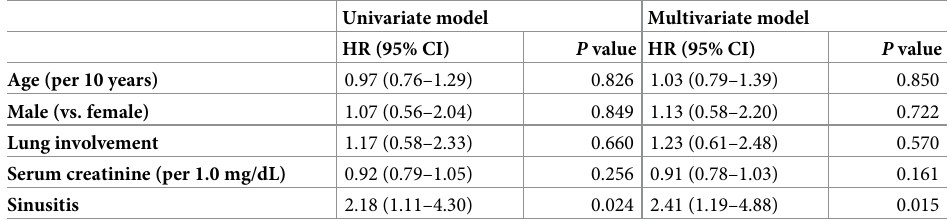
Table 2. Predictors of the first